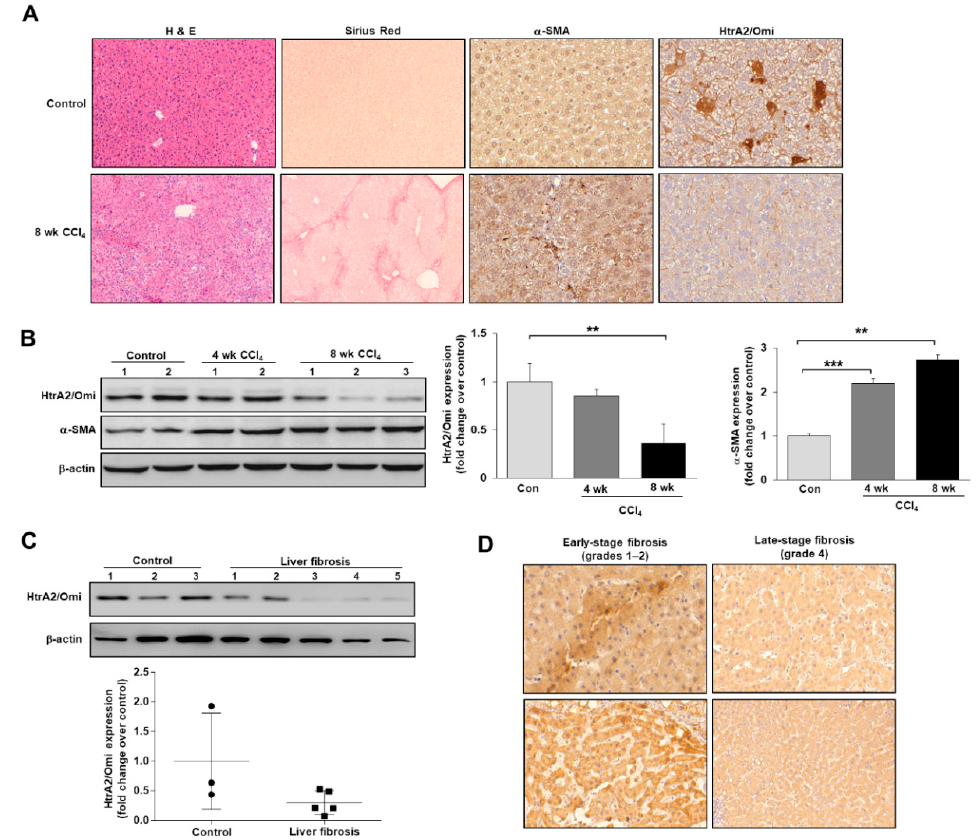
Figure 2. HtrA2/Omi expression is downregulated in CCl 4 -induced liver fibrosis and human fibrotic livers. ( A ) Representative images of H&E, Sirius red (original magnification, X200) and immunohistochemistry staining (X400) of liver sections. ( B ) Western blot analysis of HtrA2 /